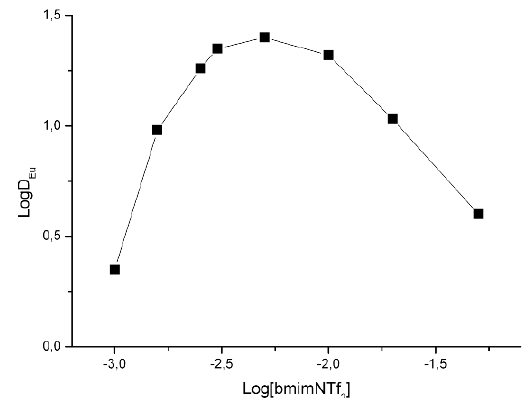
Figure 7. Influence of [bmim][NTf of Eu(III) from 1×10 -5 M Eu(NO solution of compound 8 in 1,2-dichloroethane.